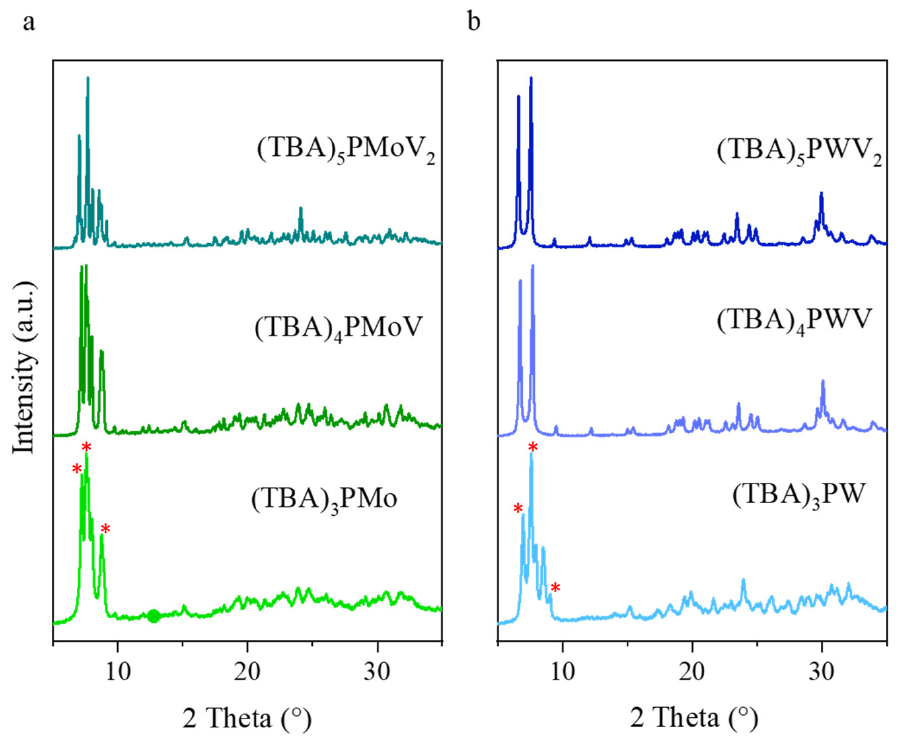
Figure 3. XRD patterns of pure and V-substituted Mo ( a ) and W ( b ) Keggin-type polyoxometalates. The red symbol represents the comparison between equivalent diffractograms with JCPDS cards.